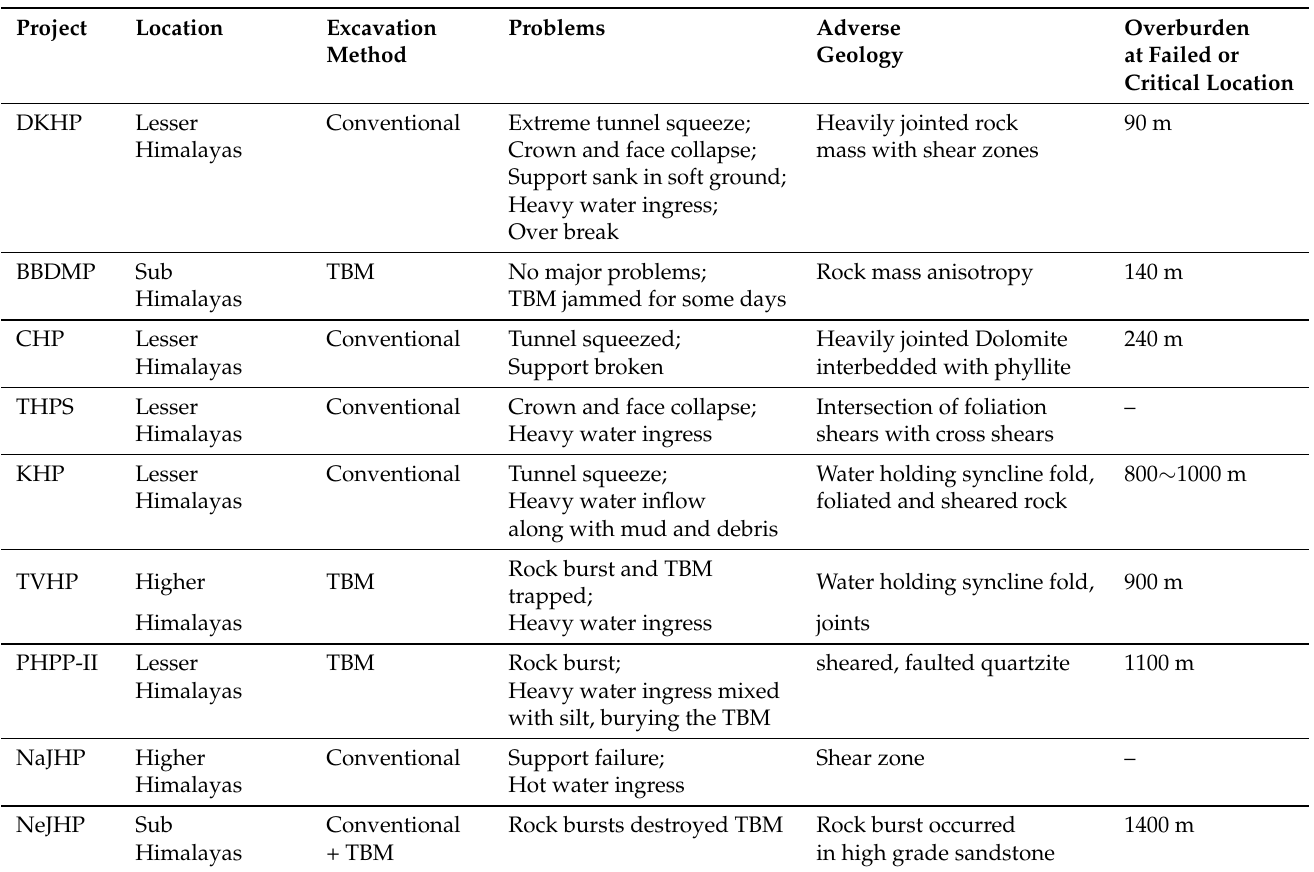
Table 1. Summary of major characteristics of the tunnel projects surveyed; the failed or critical location refers to the location where tunnel squeeze, or rock burst, or TBM trapping occurred as described in the